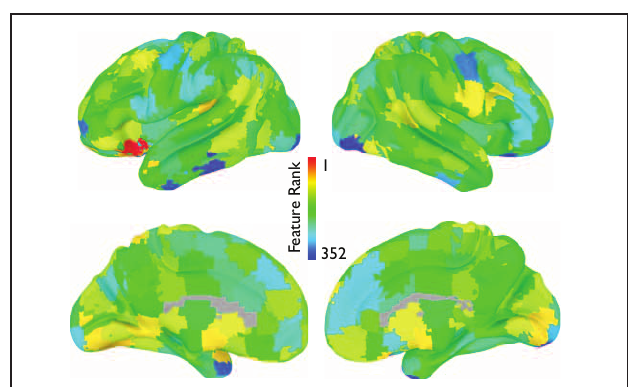
FIGURE 11 | Power spectrum feature rankings (NYU site). For each ROI in the CC400 atlas, the average feature rankings across each frequency bin of the power-spectrum are displayed. Warmer colors indicate more useful